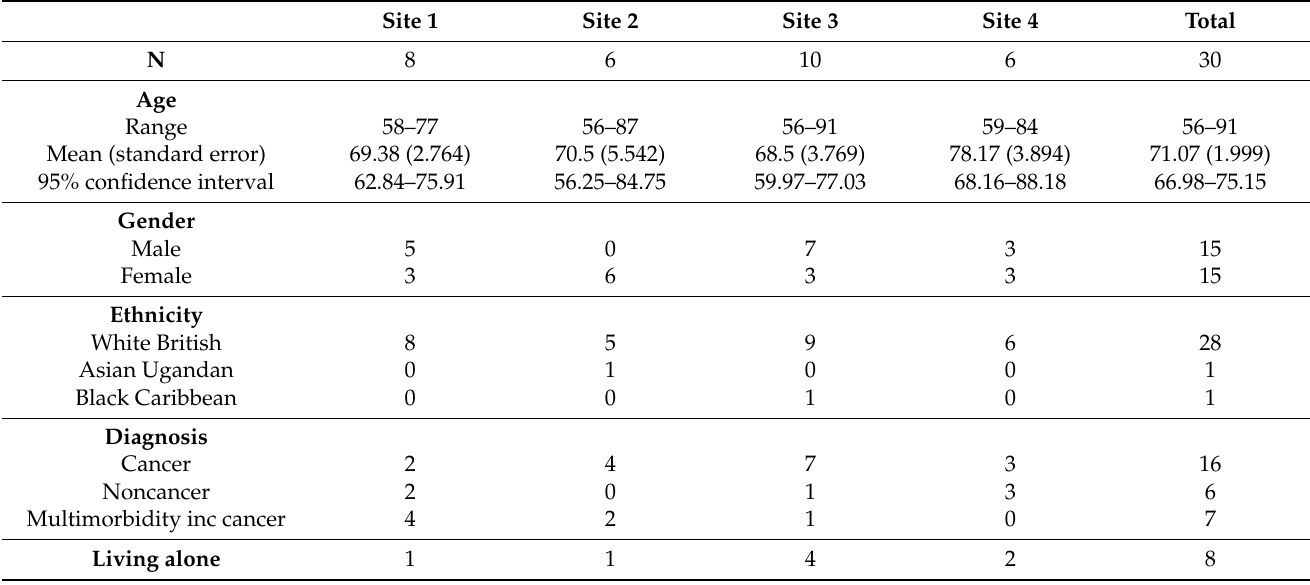
Table 3. Participant demographics and clinical features. Note: Diagnoses missing for one participant in site